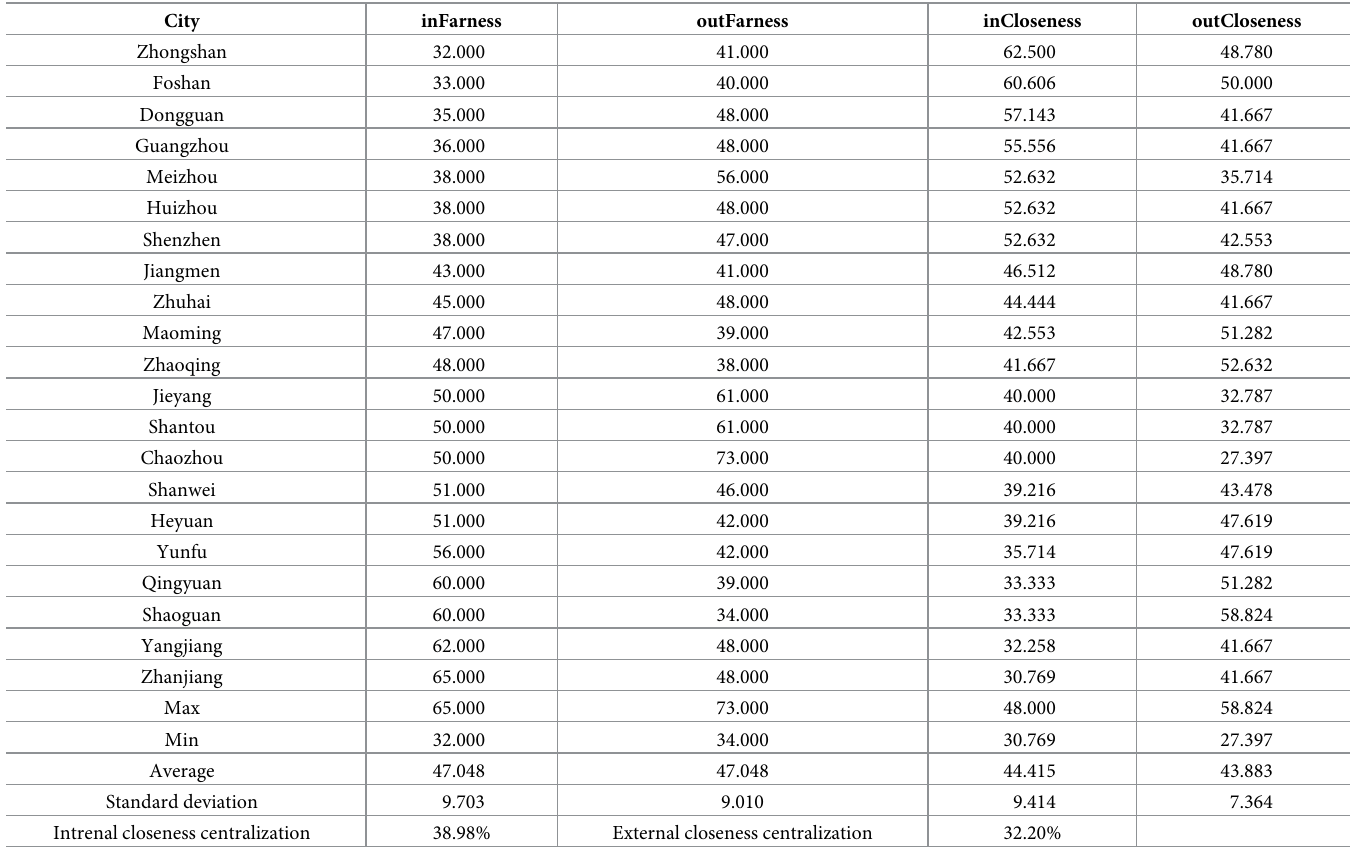
Table 9. Closeness centrality of the spatial correlation